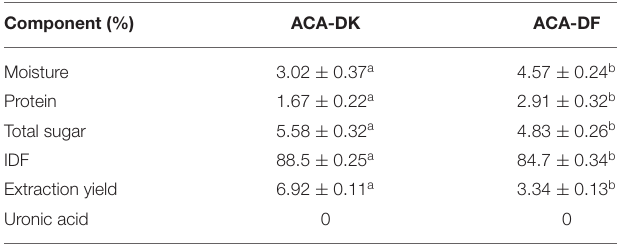
TABLE 1 | Chemical composition and physicochemical properties of ACA-DK and ACA-DF. Component (%)